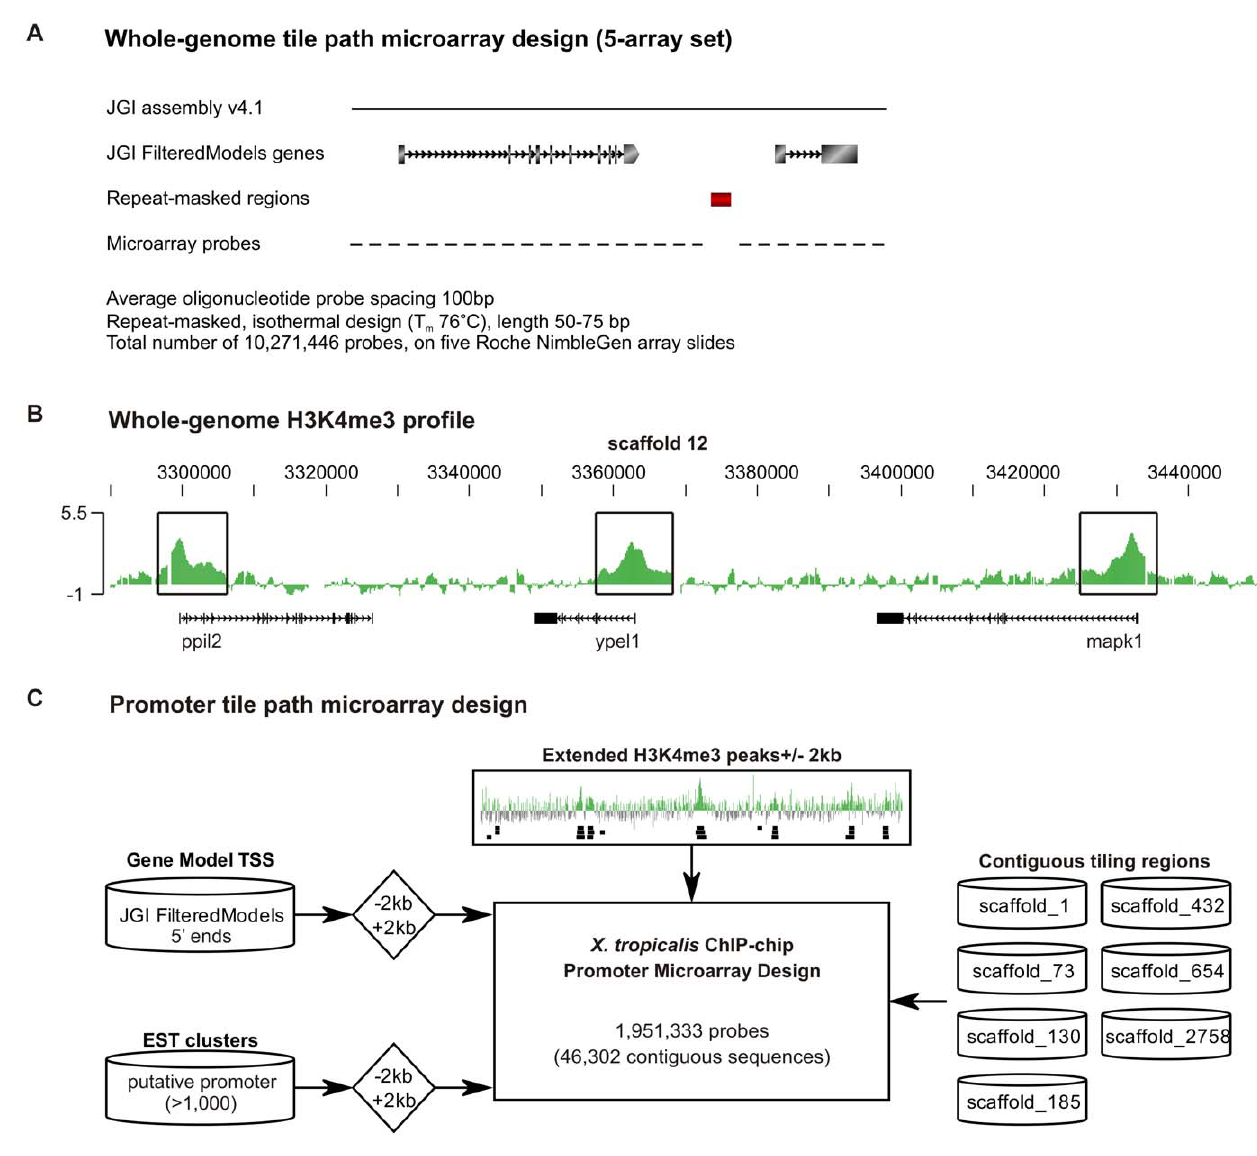
Figure 1. Whole-genome H3K4me3 ChIP-chip of gastrula embryos. ( A ) Overview of the whole-genome tile path microarray design. ( B ) H3K4me3 profile for peptidylprolyl isomerase cyclophilin-like 2 ( ppil2 ), yippee-like 1 ( ypel1 ) and mitogen-activated protein kinase 1 ( mapk1 ) that are enriched with H3K4me3 signals at the 5 9 end visualized using the UCSC Genome Browser. ( C ) Overview of the promoter tile path microarray design.